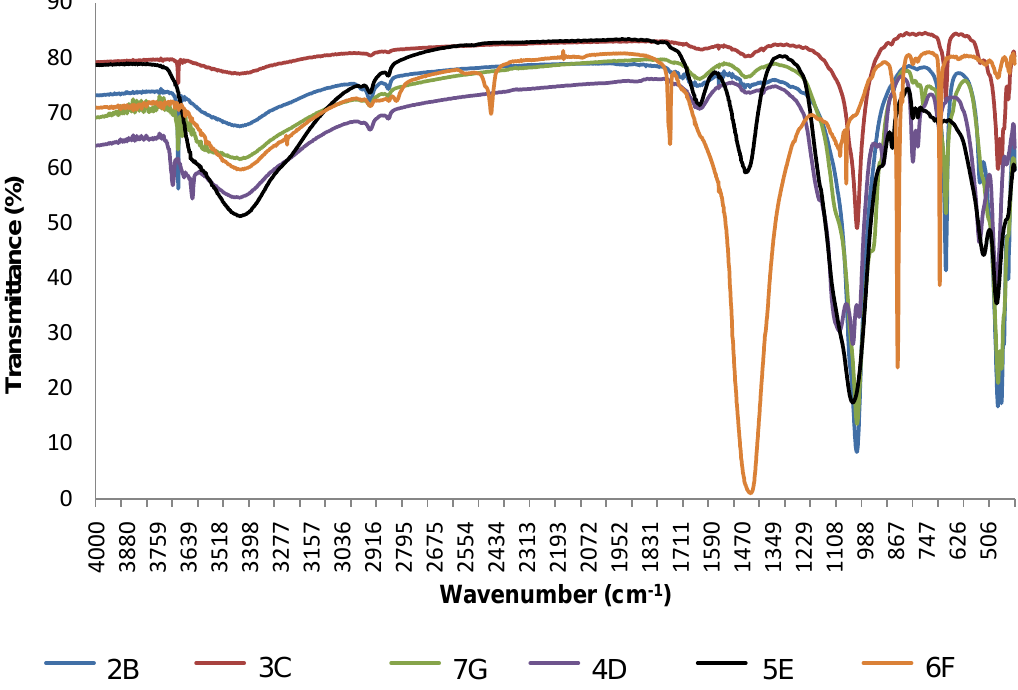
Figure 2. Fourier Transform Infrared spectra of the ceramic raw materials (Table 1) used by Rauschert Portuguesa.